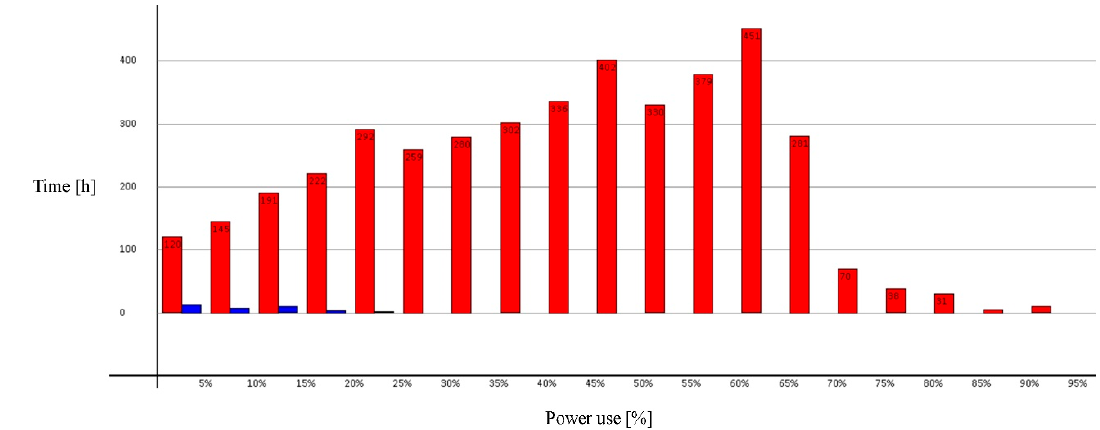
Figure 5. Percentage distribution of power used by the heating and cooling systems in the living area.